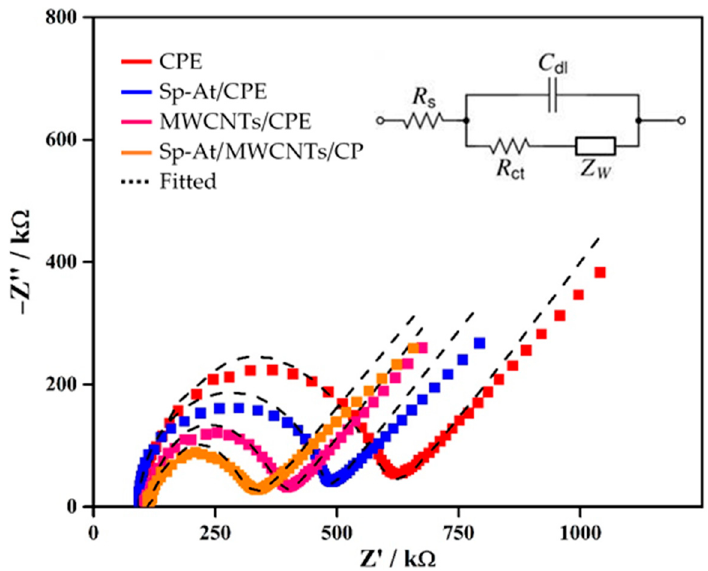
Figure 2. Nyquist plots of CPE, Sp-At/CPE, MWCNTs/CPE, and Sp-At/MWCNTs/CPE in a solution of 0.1 M KCl containing 5 mM [Fe(CN) 6 ] 3 − /4 − at the frequency range of 0.1 Hz–100 kHz, applied potential of 0.23 V and an amplitude of 5 mV. Inset: The Randles ‐ equivalent circuit model.